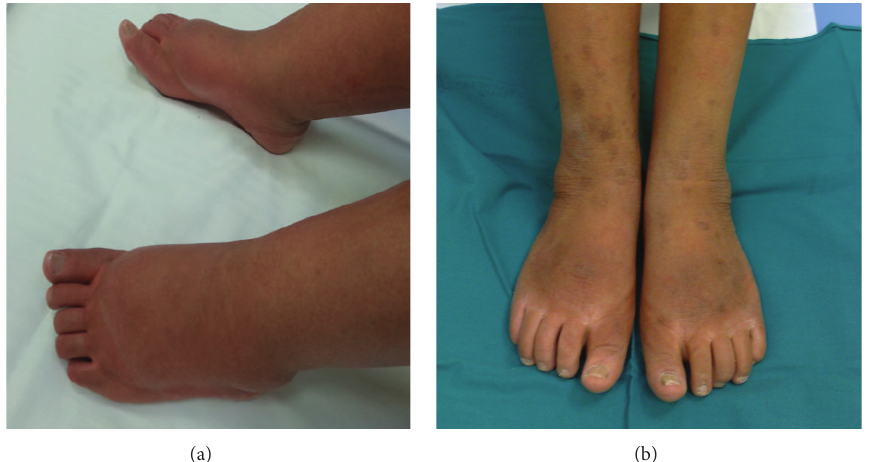
Figure 2: Patient legs and feet delaying pump recharging of 4 days (a) and after one week of pump recharging with usual dosage of Ziconotide